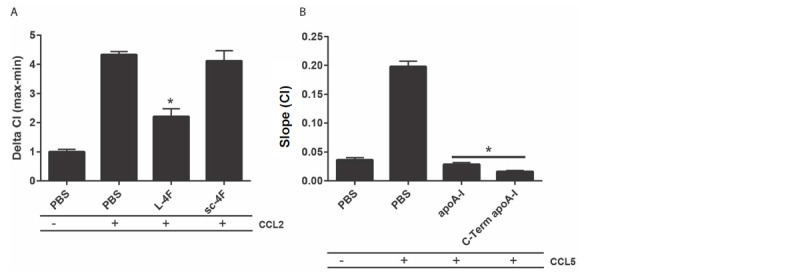
Peptides incorporating apoA1 amphipathic α-helices impair macrophage migration.Biogel elicited macrophages were and incubated with either (A) 50 µg/mL L-4F (Ac-DWFKAFYDKVAEKFKEAF-NH2), 50 µg/mL scrambled peptide (sc-4F) (Ac-DWFAKDYFKKAFVEEFAK-NH2) or (B) 40 µg/mL apoA1, 40 µg/mL C-terminal deleted apoA1 (Δ185-243) or PBS as vehicle control, before being added to the upper chamber (4×105/well) of a CIM-16 plate and allowed to migrate for 7-8 h toward 10 nM CCL2 or CCL5. Migration was measured by max-min or slope analysis. Data are expressed as mean + SEM, n = 2 biological replicates with 3-4 technical replicates per condition. Statistical analysis was conducted by one-way ANOVA with Dunnett’s multiple comparison post-test. * p,0.05 relative to 10 nM chemokine alone.